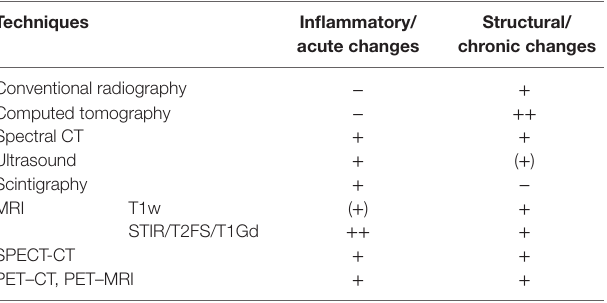
TAble 1 | Overview of the imaging techniques available for use in axial spondyloarthritis. Techniques